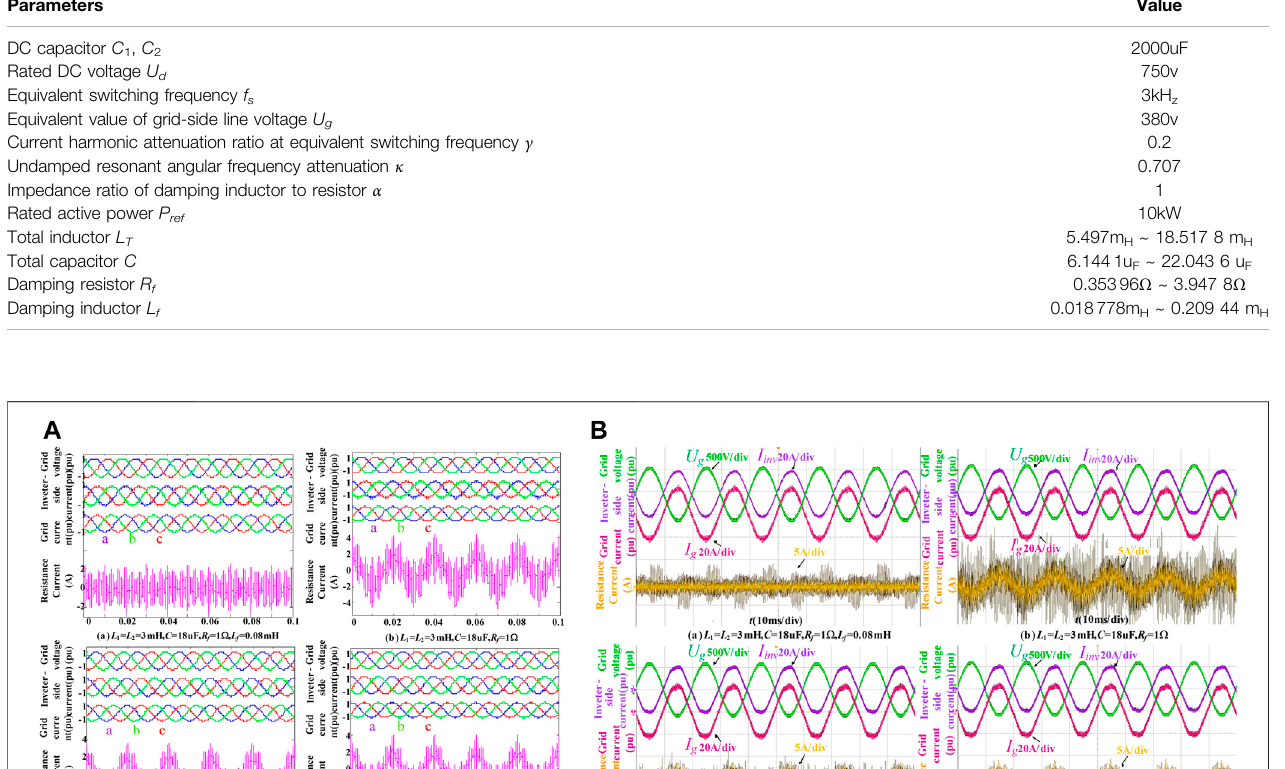
TABLE 2 | System parameters. Parameters